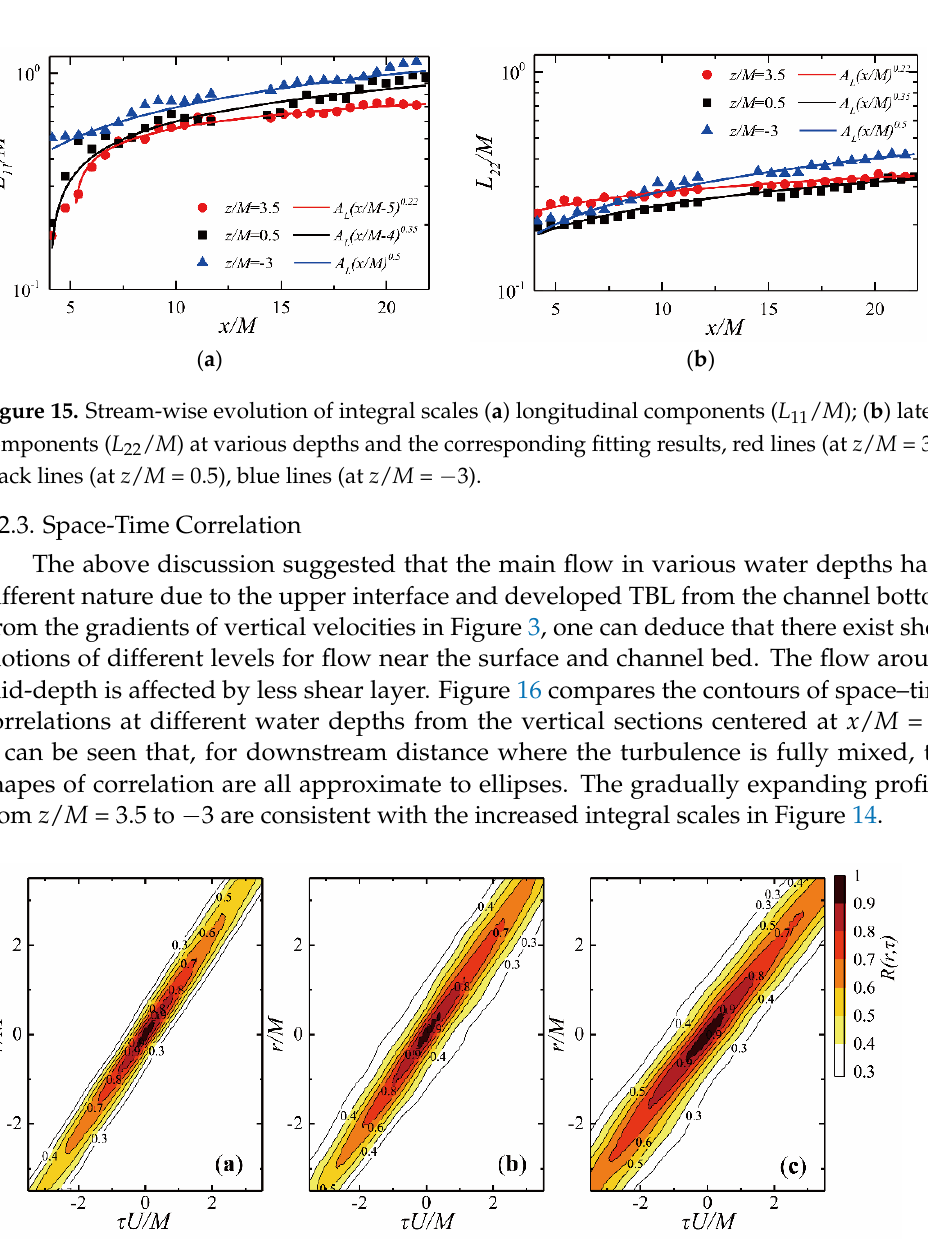
Figure 16. Space-time correlations of stream-wise velocities at various depths ( a ) z / M = 3.5; ( b ) z / M = 0.5; ( c ) z / M = − 3.